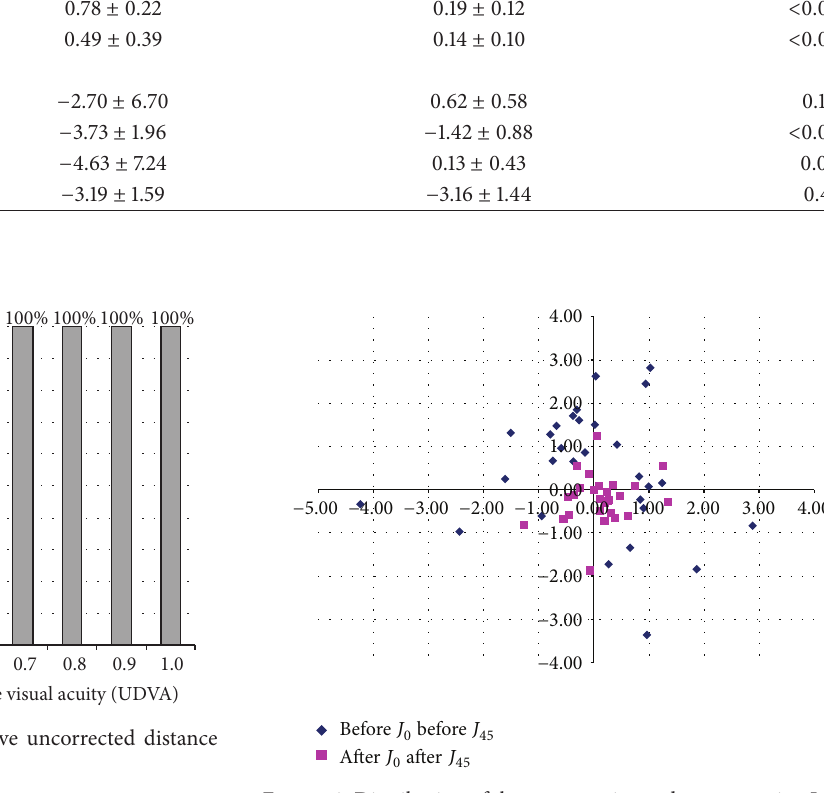
Figure 2: Distribution of the preoperative and postoperative 𝐽 0 and 𝐽 45 vectors representing the refractive